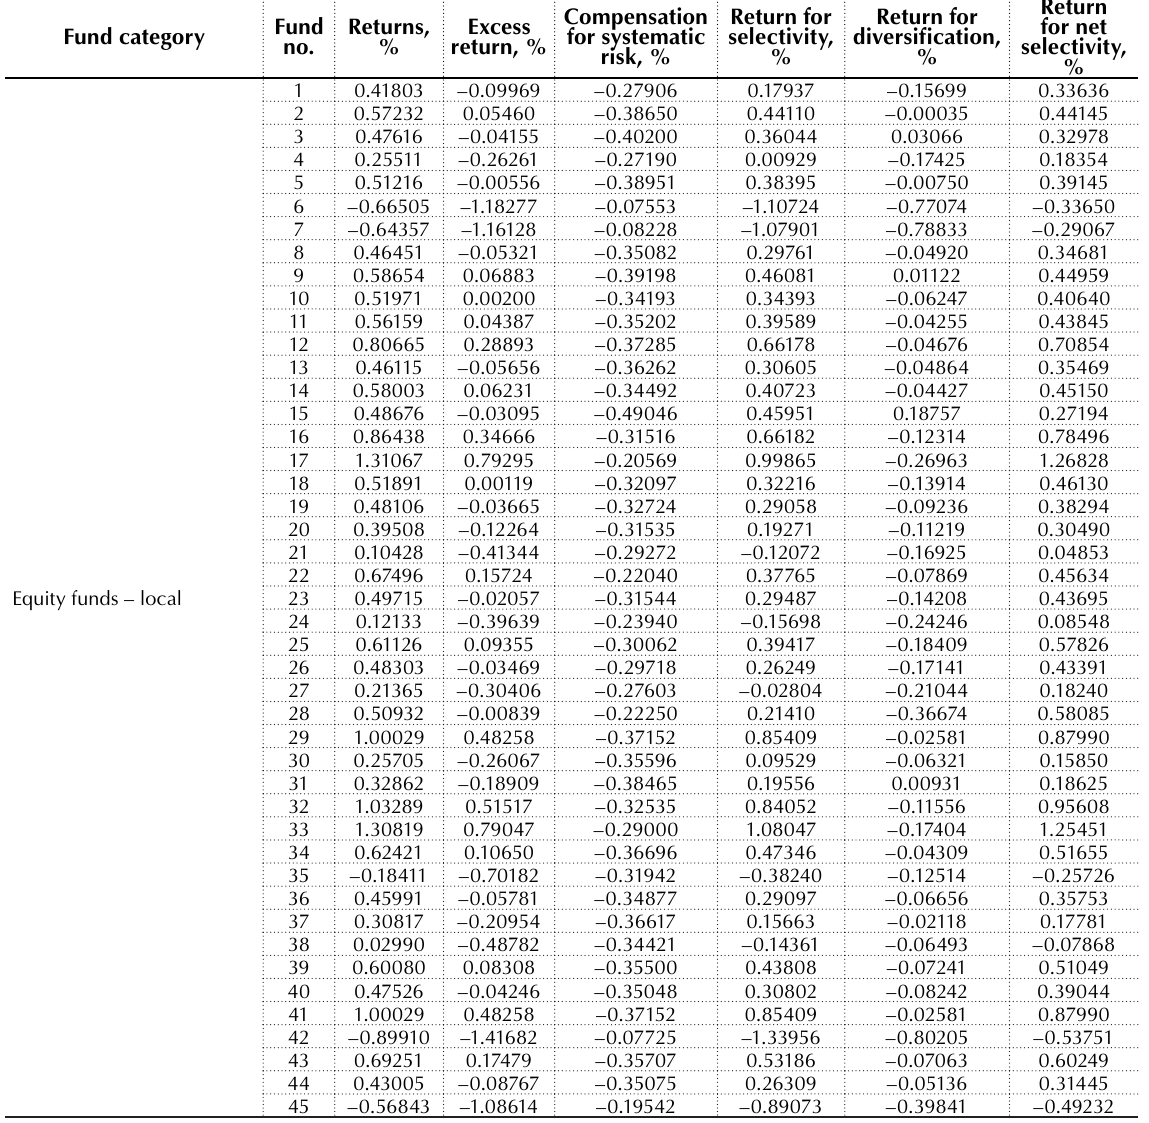
Table 2. Fama’s break up of Saudi equity funds